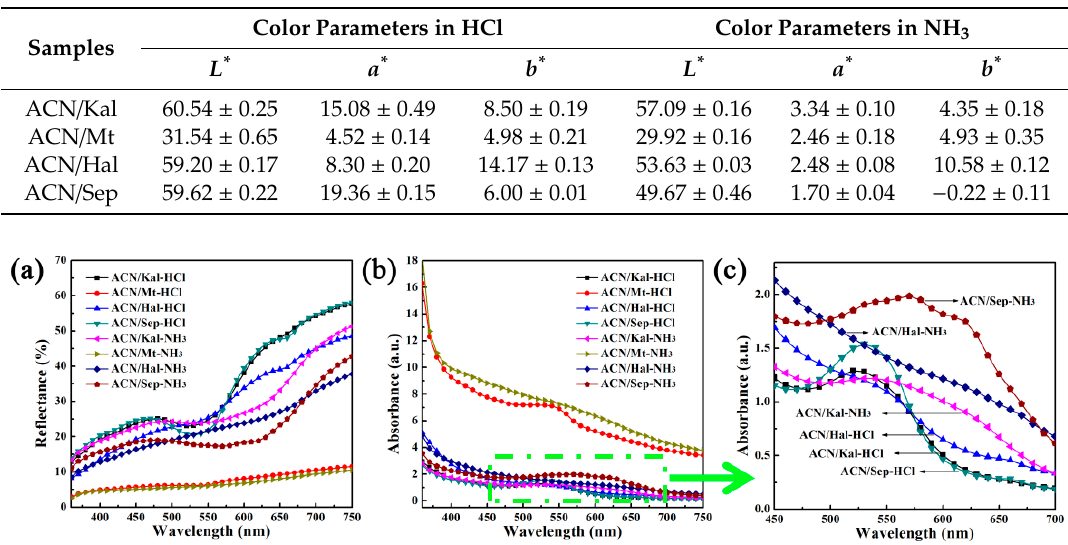
Figure 7. ( a ) UV-vis diffuse reflectance spectra, ( b ) UV-vis spectra, and ( c ) the partial enlarged view of UV-vis spectra of hybrid pigments after being exposed to acid and alkaline atmospheres for five cycles, respectively.